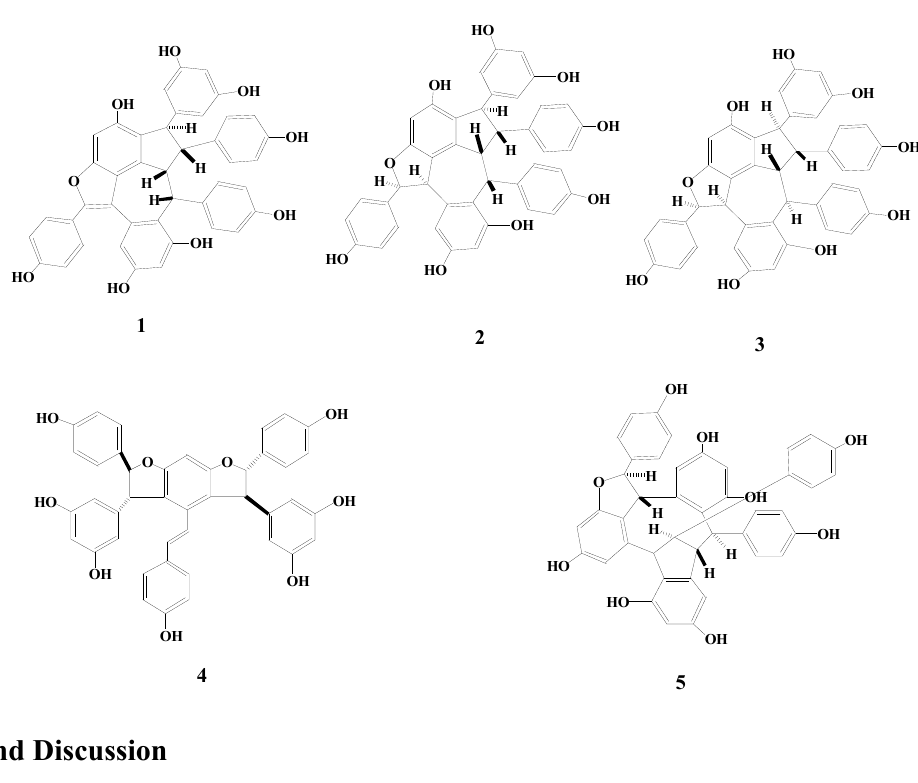
Figure 1. Structures of Compounds 1 – 5